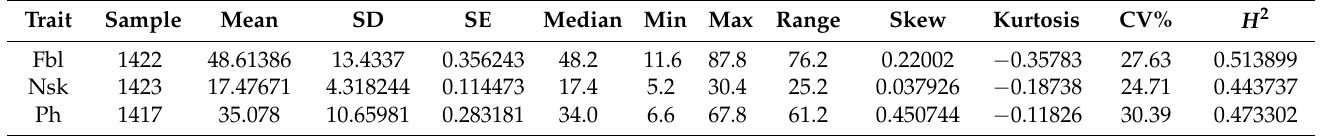
Table 1. Phenotypic Statistics of the Three Studied Plant Height Related Traits.